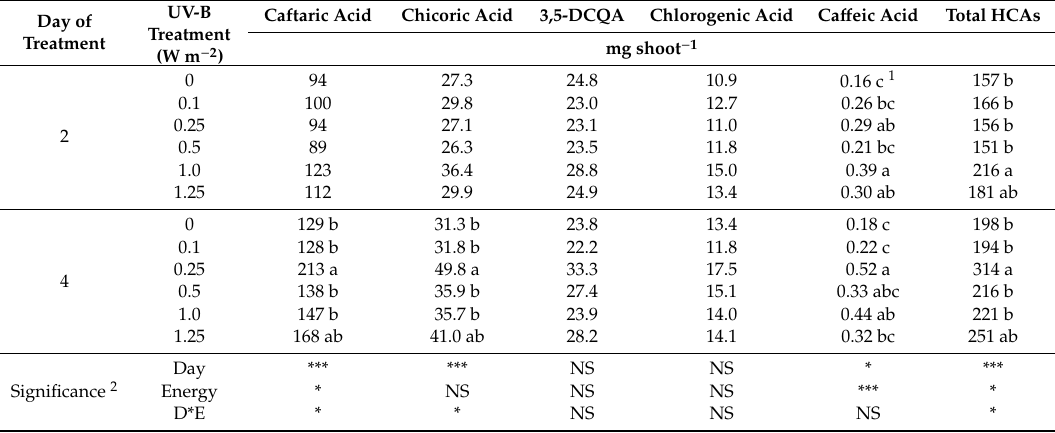
Table 1. Hydroxycinnamic acids (HCAs) contents in C. denticulatum subjected to different energy levels of UV-B radiation at 2 and 4 days of treatment. Plants were subjected to UV-B treatments at 5 weeks of transplanting.